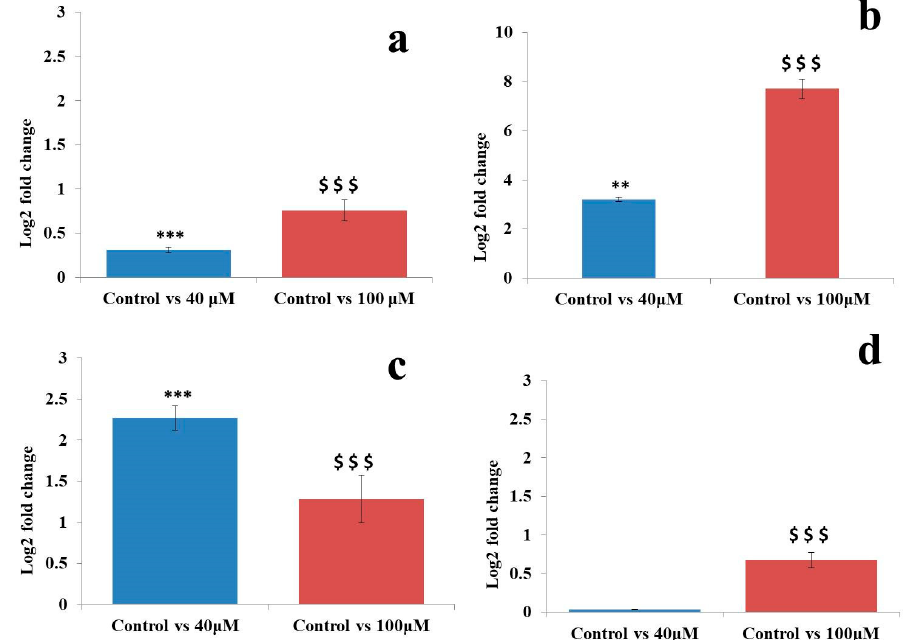
Figure 10. Validation of randomly selected known microRNAs by qRT-PCR. ( a ) Log2 fold change of miR-21-5p; ( b ) Log2 fold change of hsa-miR-548o-5p; ( c ) Log2 fold change of hsa-miR-181c; ( d ) Log2 fold change of hsa-miR-212-5p microRNAs. The significant difference between the untreated control vs. 40 and the untreated control vs. 100 μ M EGCG treatmts are indicated by ‘ ∗’ between untreated control and 40 μ M EGCG treatment, and ‘$’ between untreated control and 100 μ M EGCG treatment. Significance levels of p <